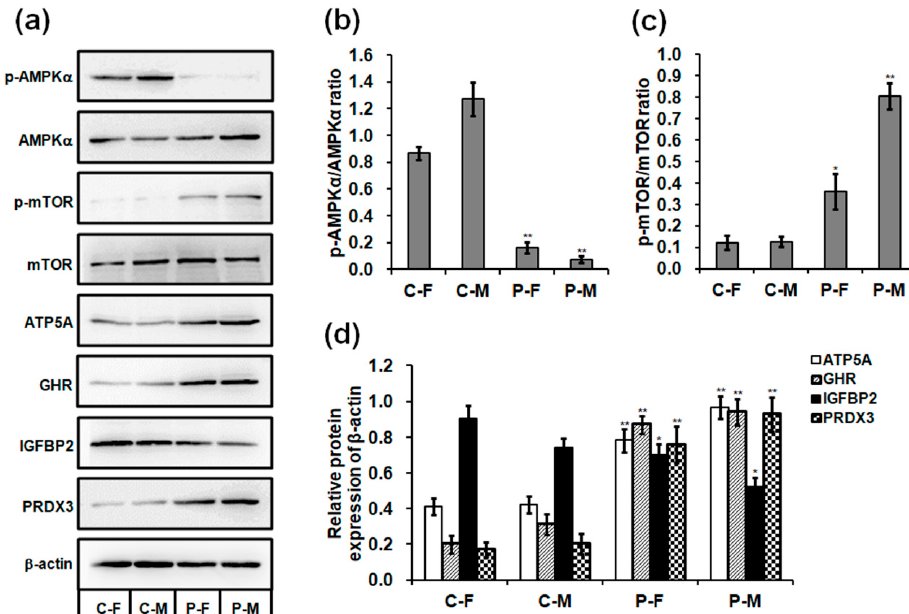
Figure 7. Effect of plasma on protein expression in 90-day-old chickens. ( a ) Western blot analysis of protein bands in the skeletal muscles. Uncropped immunoblot scans are presented in Figure S1. Relative protein levels of ( b ) p-AMPK α /AMPK α , ( c ) p-mTOR/mTOR, and ( d ) ATP5A, GHR, IGFBP2, and PRDX3. Data are presented as mean ± SD ( n = 3) of three replicates; n represents an individual chicken. *, p < 0.05 versus control; **, p < 0.01 versus control in females and males, respectively, according to the one-way ANOVA with an LSD test.